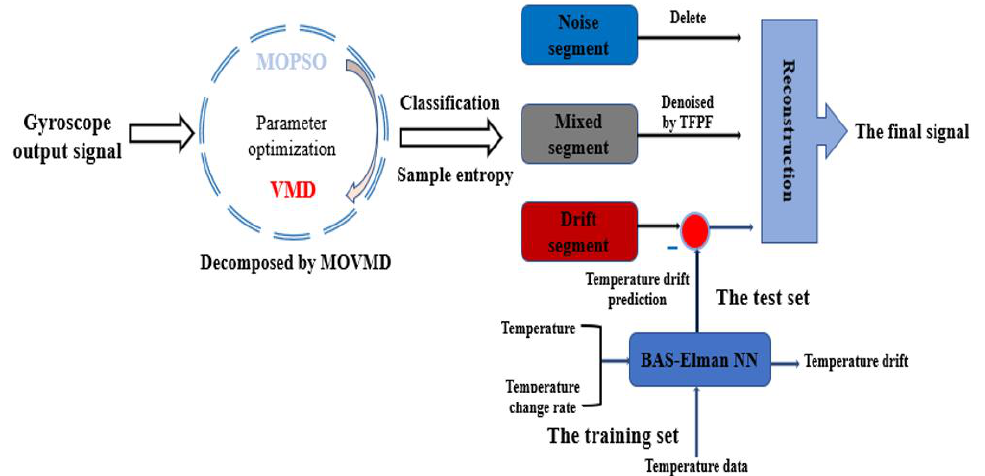
Figure 7. Parallel processing model based on MOVMD – TFPF and BAS – Elman NN.